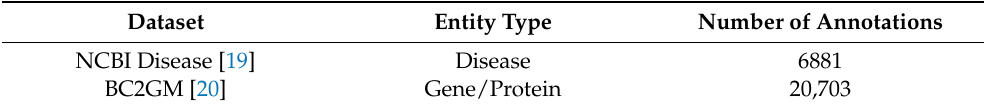
Table 3. Statistics of NER datasets.